Question: Briefly state, in one sentence, what is plotted here.
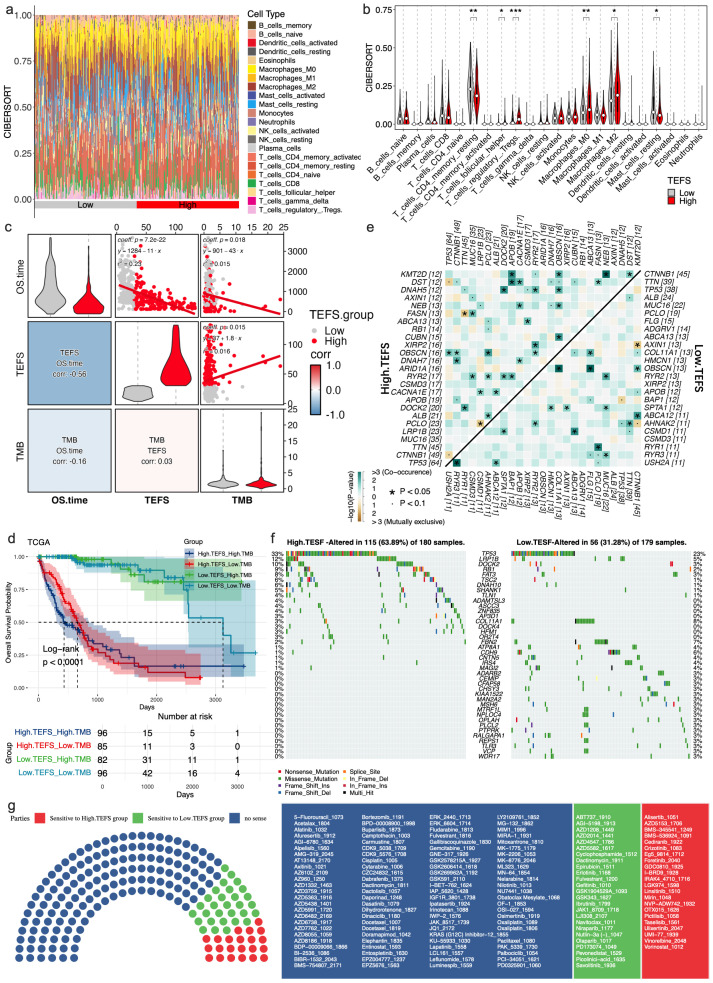
Answer: Immune infiltration microenvironment remodeling, mutational profiling, and drug sensitivity analysis based on TEFS scores. (A) Immune infiltration analysis of high- and low-risk groups identified by the model, using the CIBERSORT method. (B) Violin plots showing the infiltration levels of various immune cell types. (C) Correlation of tumor mutational burden score with TEFS score and OS. (D) Kaplan-Meier curve analysis of OS combining TMB score and TEFS score. (E) Heatmap showing the relationship between co-occurring and exclusive mutations in the top 25 mutated genes in the high- and low-risk groups. (F) Waterfall plot of the low-TEFS group showing mutations. (G) Drug sensitivity analyses between low- and high-TEFS groups. *, P<0.05; **, P<0.01; ***, P<0.001.